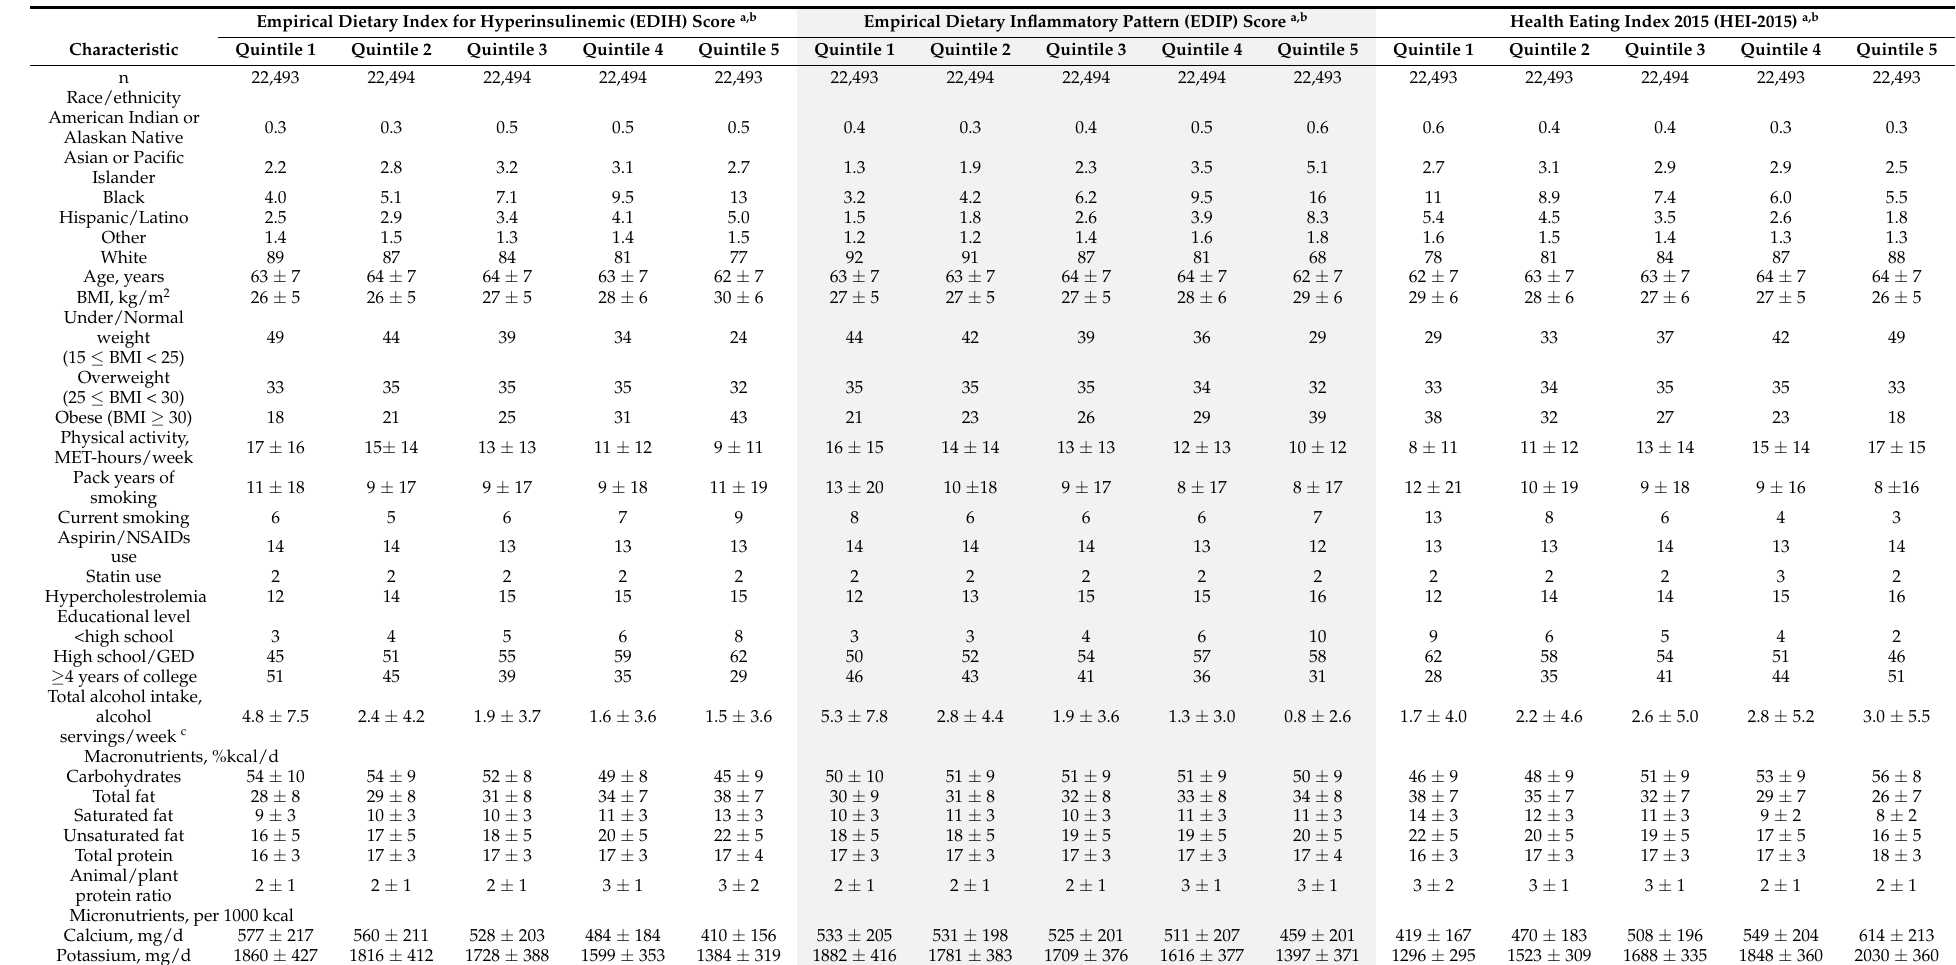
Table 1. Distribution of participant characteristics in dietary index quintiles, using the total cancer analytic sample. Empirical Dietary Index for Hyperinsulinemic (EDIH) Score a,b Empirical Dietary Inflammatory Pattern (EDIP) Score